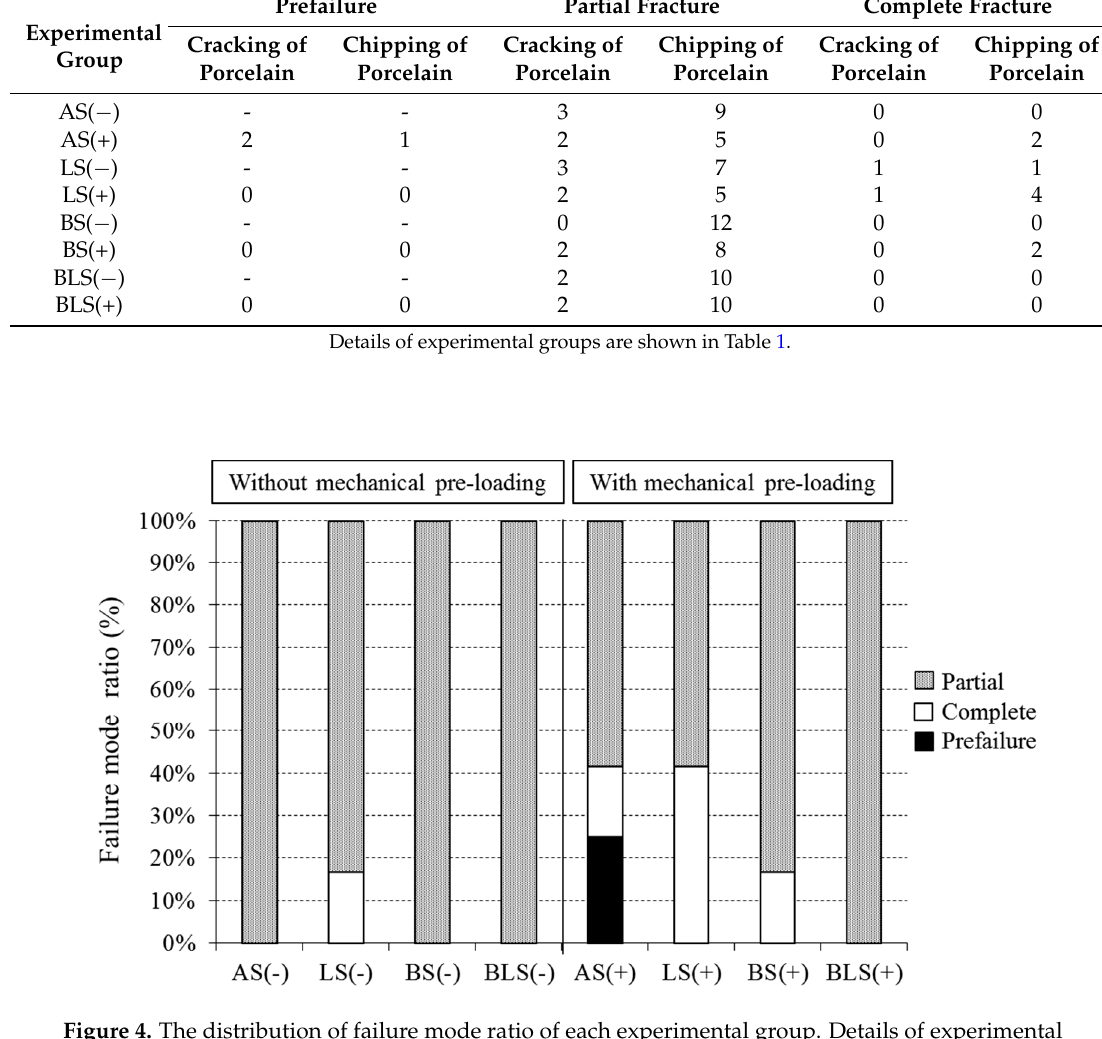
Table 3. Number of respective failure modes of all-ceramic crowns using different Ce-TZP/A framework designs.